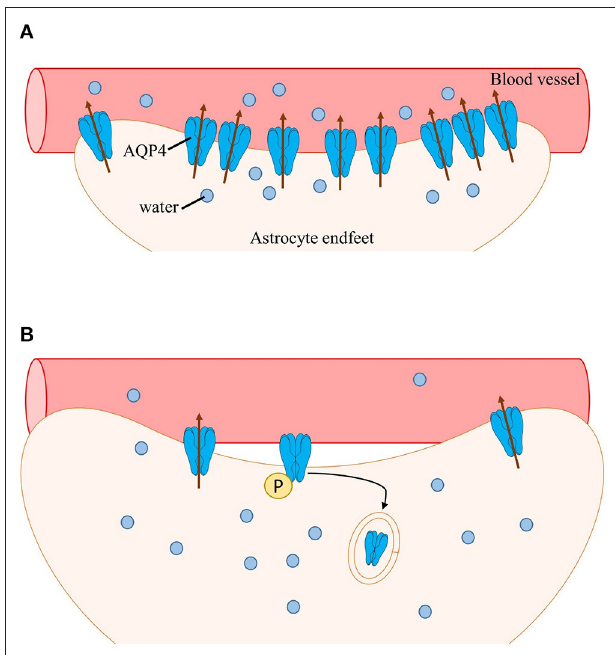
FIGURE 1 | Schematic of AQP4 subcellular mislocalization. (A) After neuronal activation, water enters astrocytes (along with other ions and neurotransmitters such as K + and glutamate). Water is then transported into nearby blood vessels via perivascular AQP4, overall maintaining water homeostasis. (B) During epilepsy, perivascular AQP4 (M23-AQP4) is lost due to loss of its anchoring protein α -syntrophin (not shown). Additionally, the rapid influx of water activates vasopressin receptors leading to phosphorylation of AQP4 by PKC followed by internalization and subsequent degradation of AQP4. Swelling of astrocytes occurs, resulting in impaired cell volume regulation and further increasing neuronal